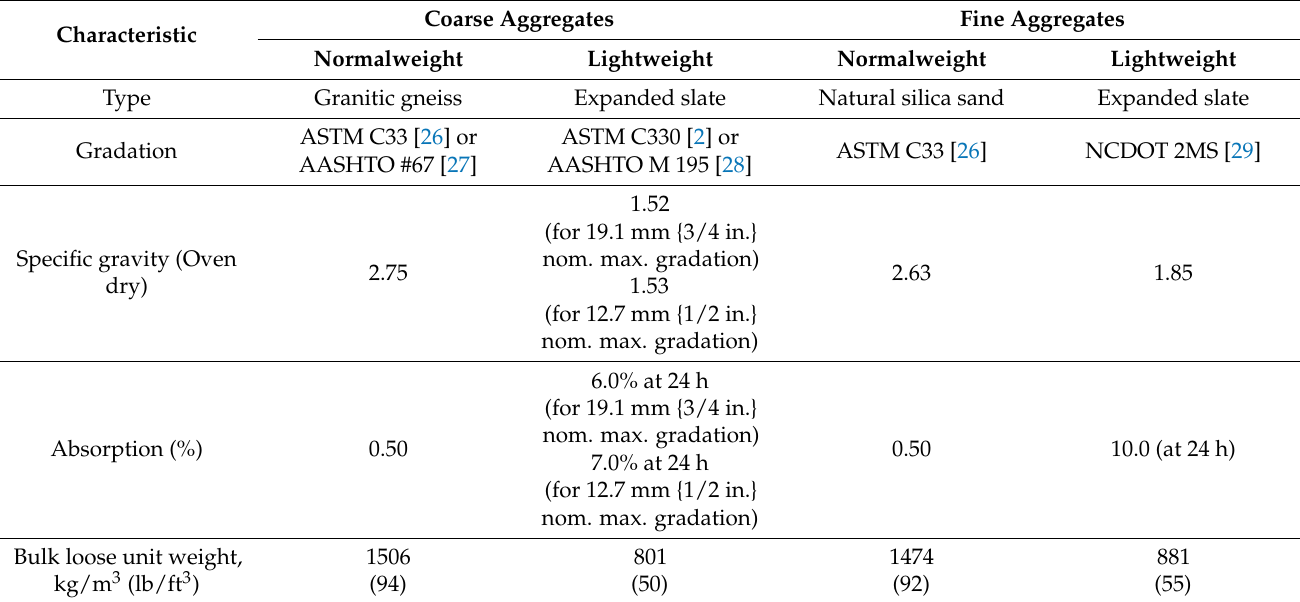
Table 1. Aggregate properties and